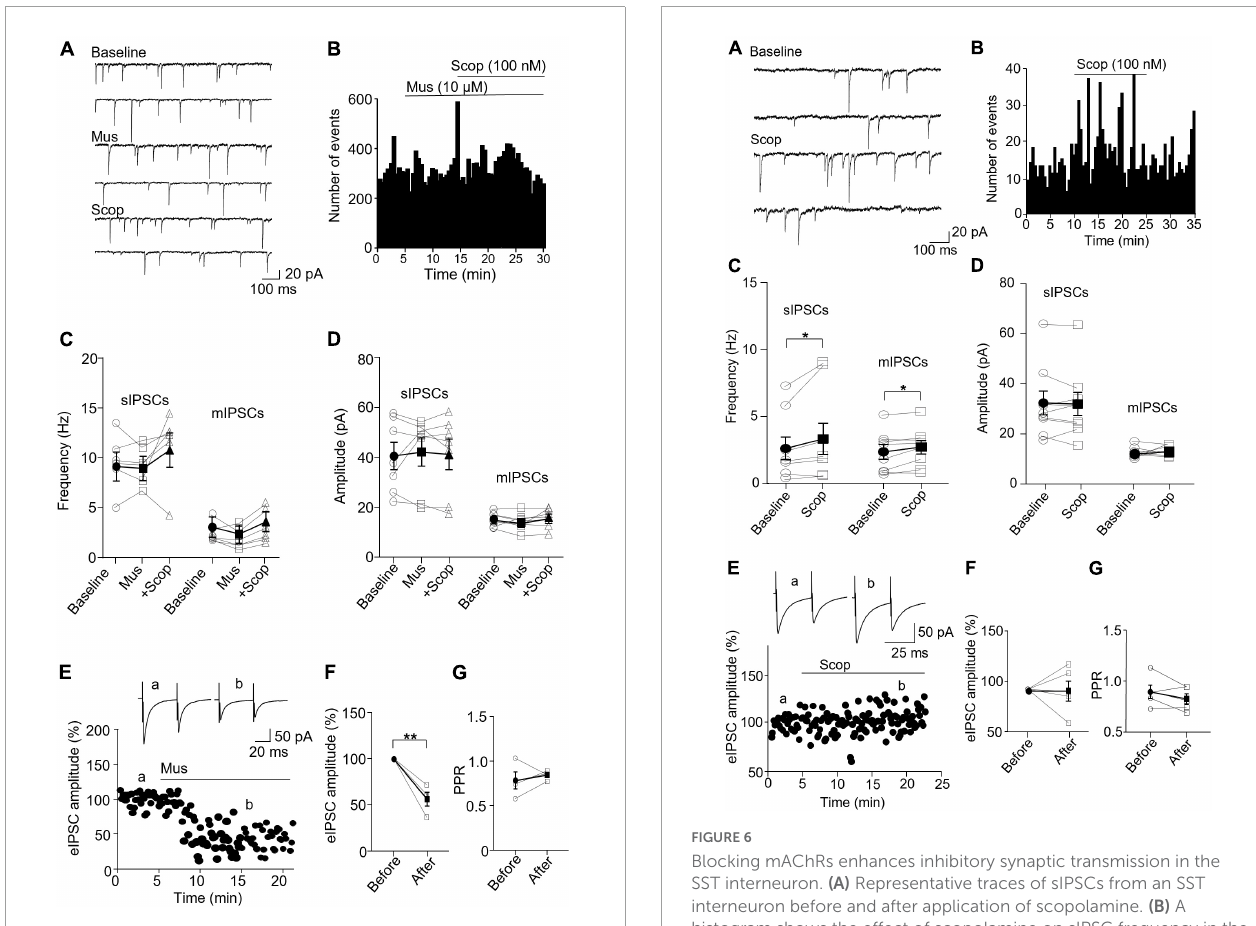
Figure 7D ]. Scopolamine did not change the amplitude of